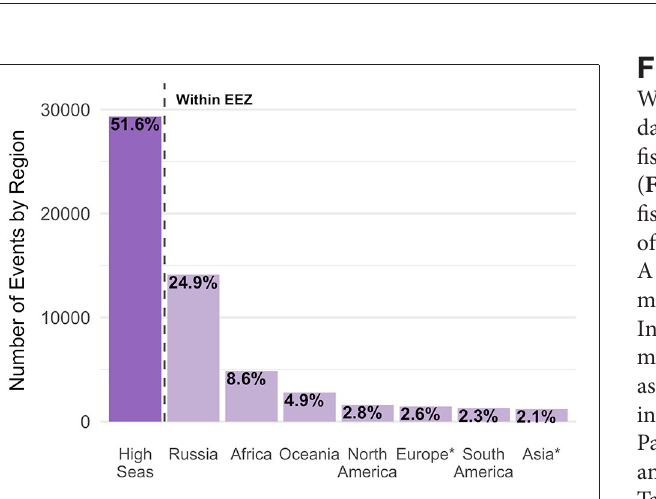
FIGURE 3 | Geographic distribution of loitering events and encounters (combined). Roughly 52% of the events occur in the high seas. *Note that Russia is presented